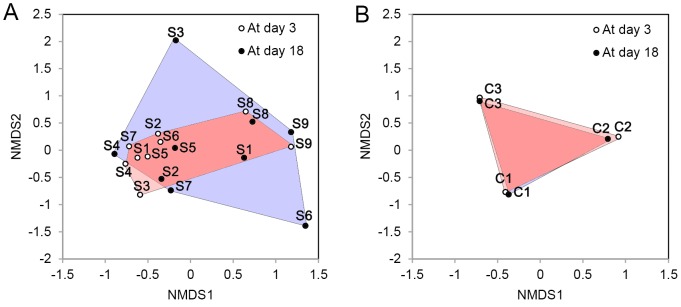
NMDS plots of bacterial community structure at day 3 and day 18 after the first egg was laid, in 9 incubated nests (A) and three control nests (B).NMDS (Nonmetric Multidimensional Scaling) plots were generated with Bray-Curtis dissimilarities between samples in 9 incubated nests, S1–S9, in (A) (2D stress  = 0.12) and 3 control nests, C1–C3, in (B) (2D stress  = 0.01). NMDS plot is mapping the bacterial structure of each sample considering the relative distances with other samples, based on both bacterial composition and abundance. Pink polygon contains all initial bacterial communities; the blue polygon encompasses all bacterial communities at the end of incubation.